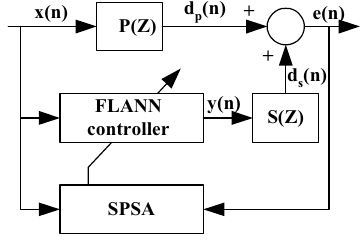
Fig. 2. The block diagram of an ANC system.